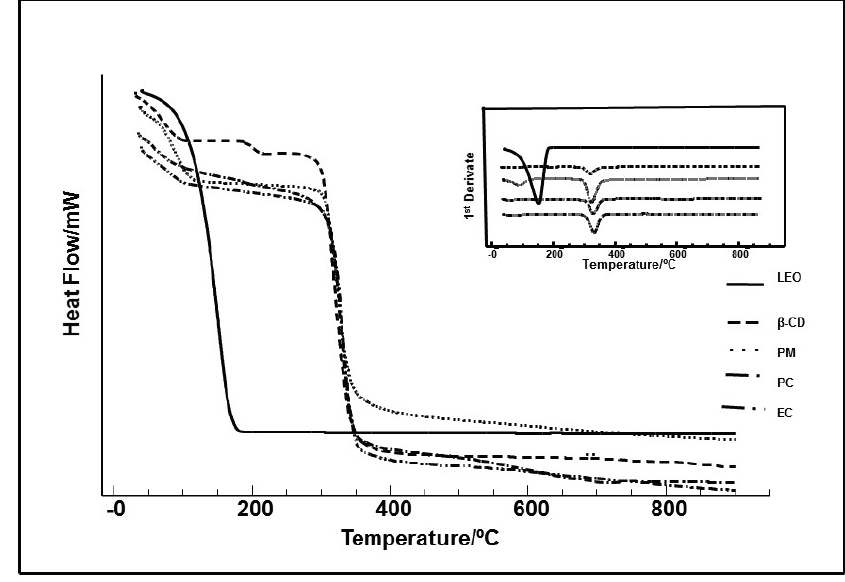
Figure 2. TG/DTG curves of the essential oil of Ocimum basilicum (LEO), β -cyclodextrin ( β -CD), physical mixture (PM), paste complex (PC) and co-evaporation (EC) obtained in a dynamic atmosphere of N 2